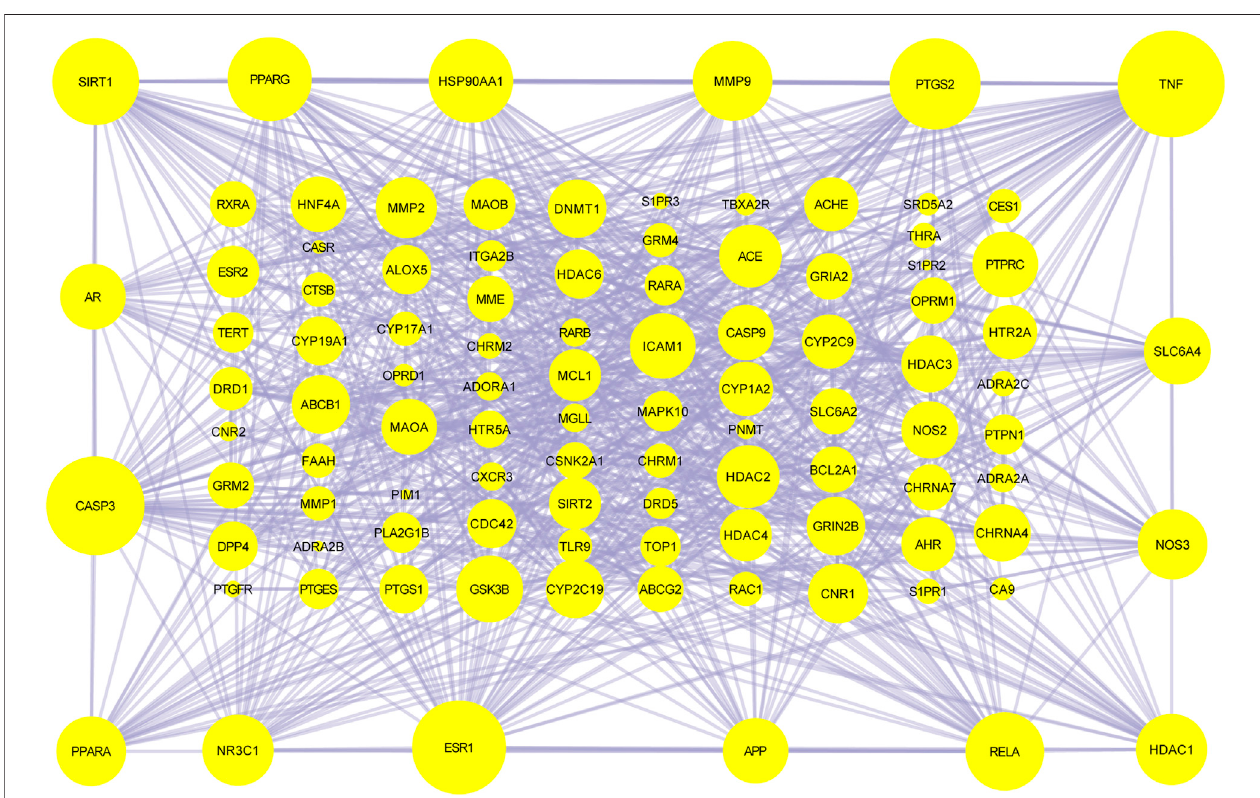
FIGURE 4 | PPI of 101 targets of Formula 9002A associated with Alzheimer ’ s